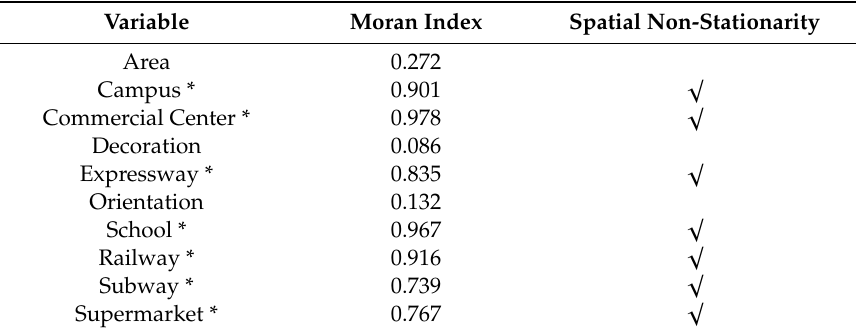
Table 3. Spatial non-stationarity test.